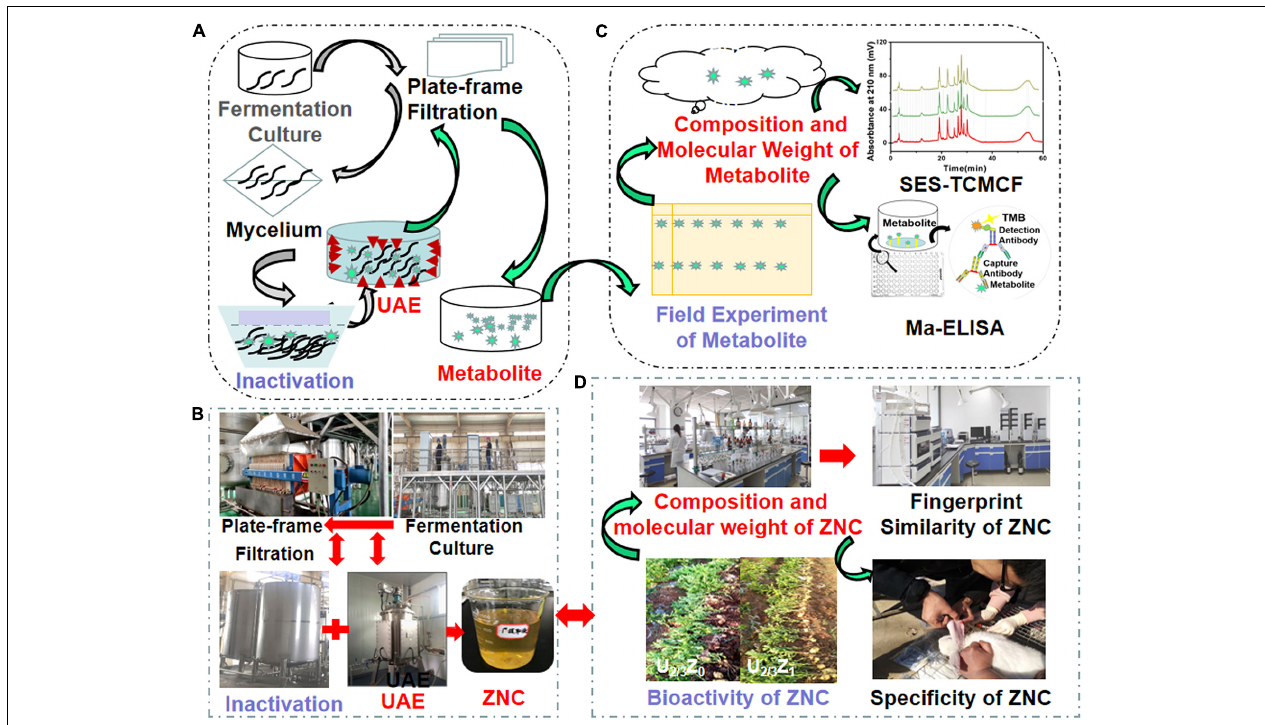
FIGURE 1 | Schematic illustration and realistic picture of extract from Paecilomyces variotii SJ1 (ZNC). (A,B) Schematic illustration of industrial extraction and evaluation of ZNC, respectively; and (C,D) realistic picture of extraction and evaluation of ZNC,